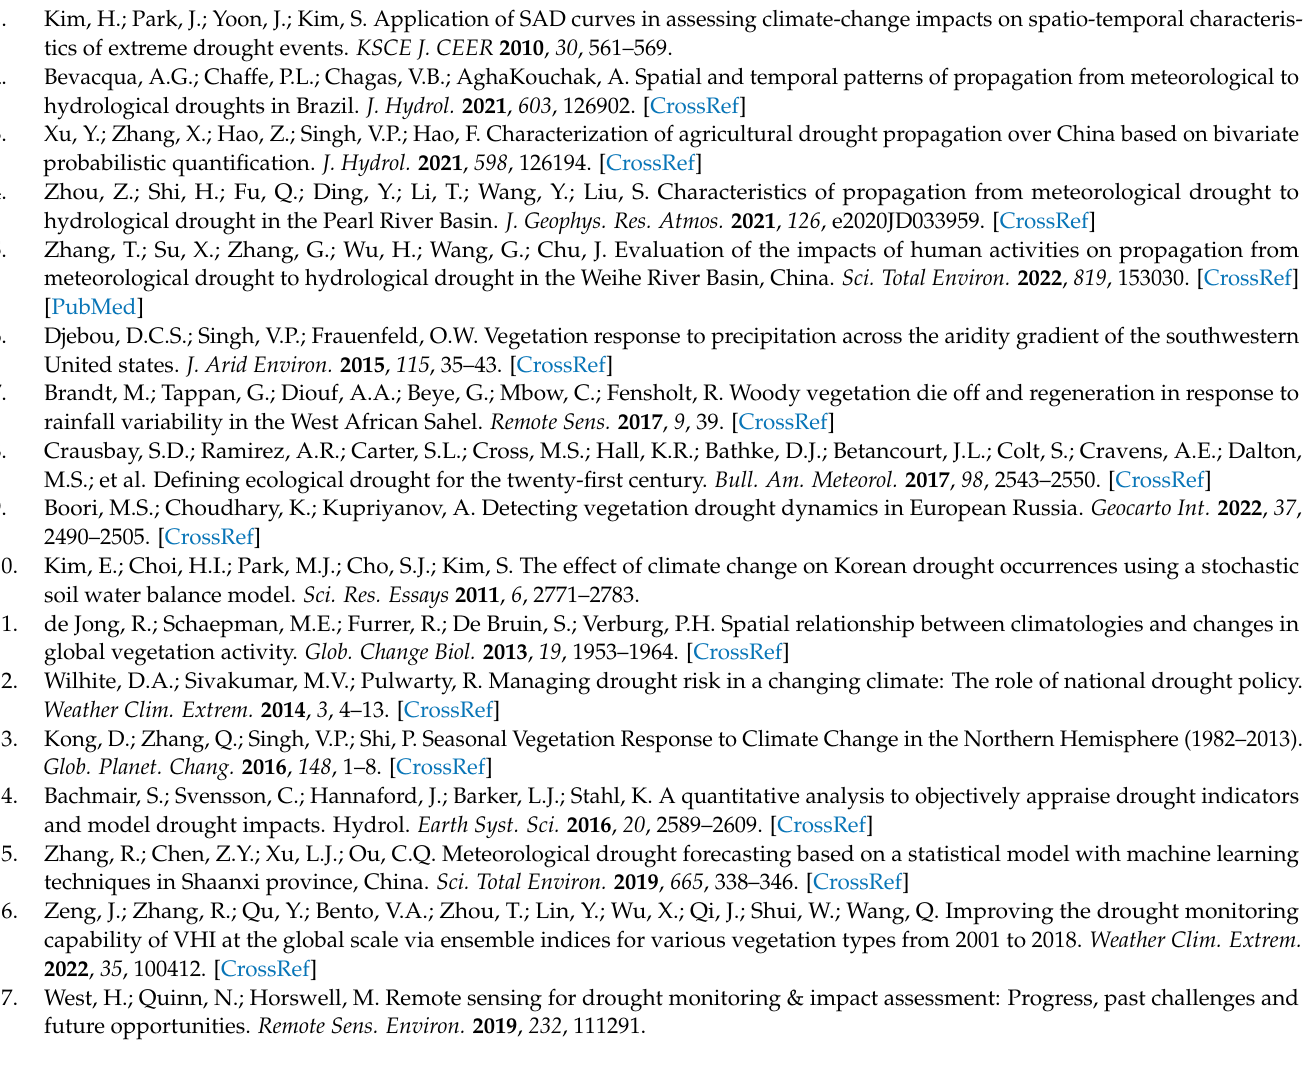
Figure S3: Time series of ecological drought monitoring by applying the ecological drought stage classification, Figure S4: Comparison of ranges of EDCI-veg values in agricultural regions of North and South